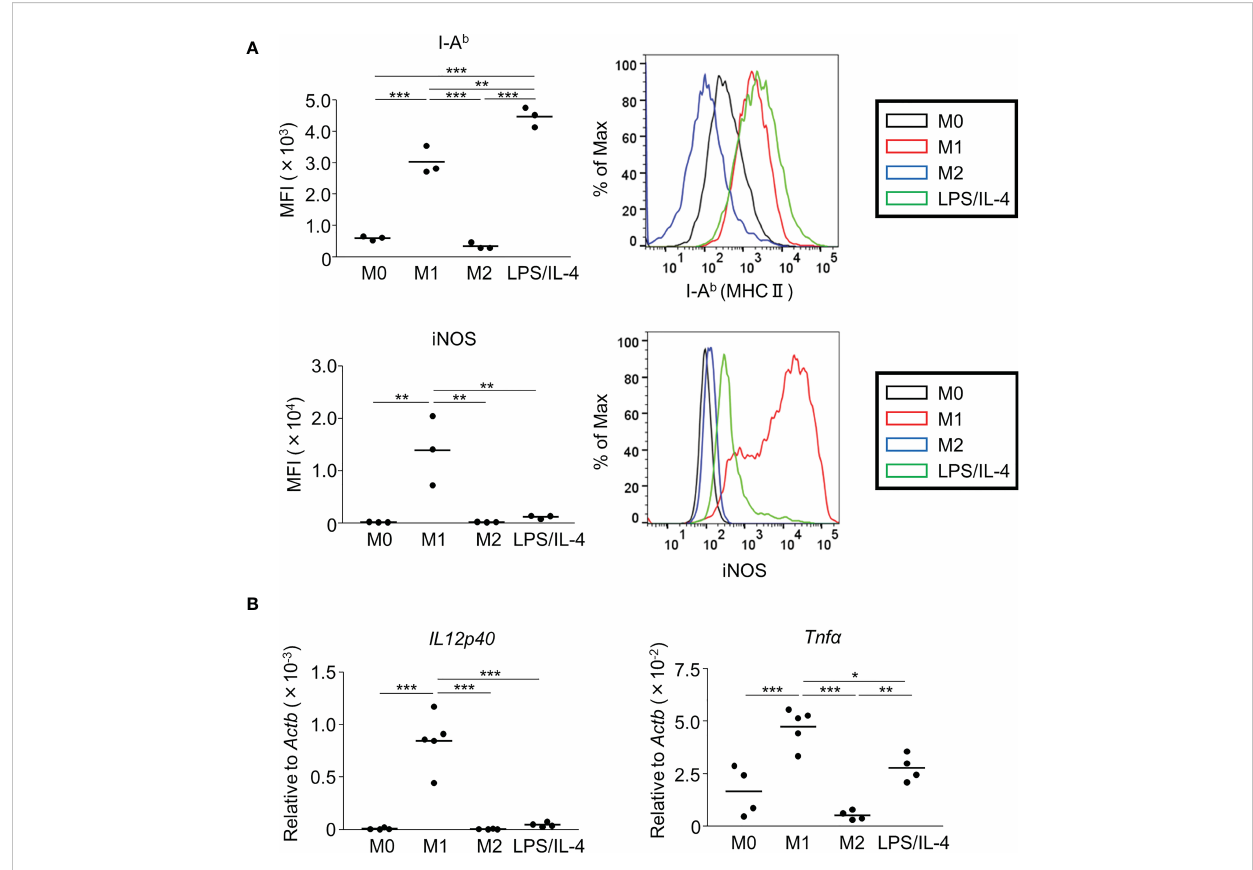
FIGURE 1 M1 marker expression pro fi les of M1 macrophages and LPS/IL-4-induced macrophages. Bone marrow-derived macrophages were prepared and stimulated with either LPS, IL-4, or LPS plus IL-4 for 24 h (A, B) . (A) Flow cytometric analysis was performed to examine the expression of M1 markers (i.e., I-A b and iNOS). Mean fl uorescence intensity (MFI) and representative histogram data are shown and gated on 7-AAD − CD45 + CD11b + F4/80 + for I-A b and gated on only 7-AAD − for iNOS. (B) Gene expression levels were examined by reverse transcription-quantitative PCR analysis. The expression levels of Il12p40 and Tnf a were normalized to that of Actb . Each point represents data from an individual experiment. Horizontal bars indicate mean value. * P <0.05, ** P <0.01, *** P